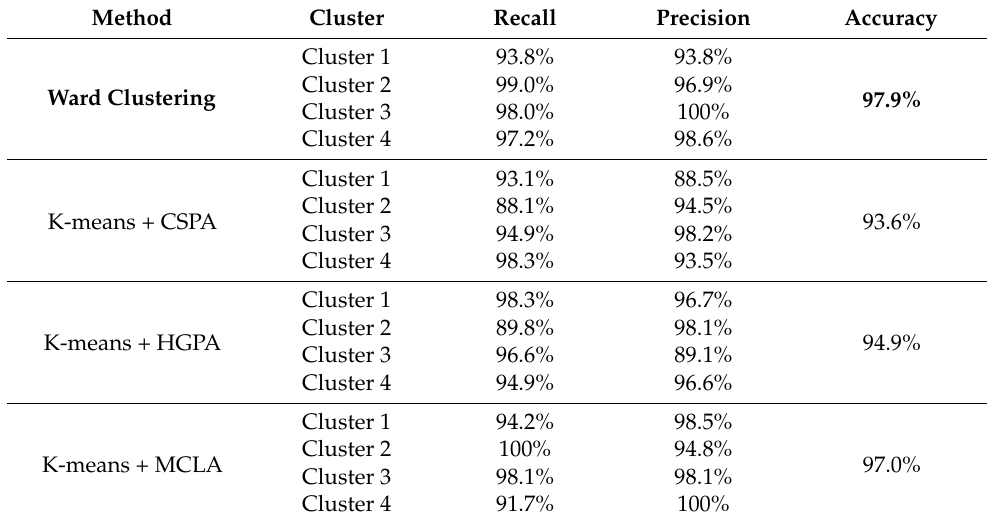
each cluster on test set.